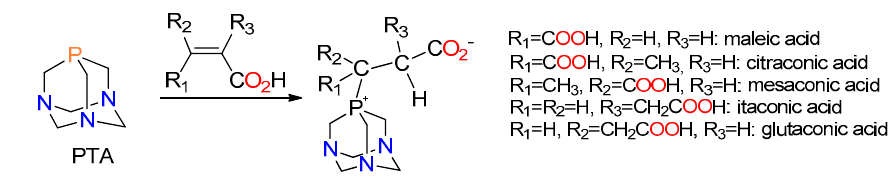
Figure 1. PTA and PTA-derived phosphonium salts.